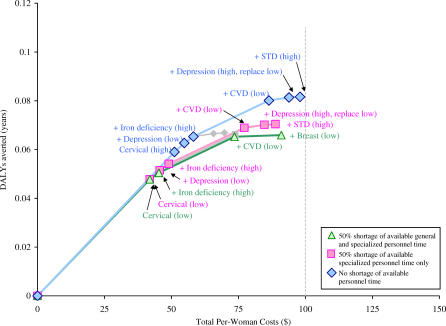
Packages of Interventions under a Lifetime Budget of $100 per Woman in AFR-D,EEach curve shows the order in which interventions are added (or substituted) when the budget is set at $100 per woman under the different scenarios of personnel time constraints: no personnel time constraints (blue), 50% constraint on specialized personnel time only (pink), and 50% constraint on both general and specialized personnel time (green). Curves in gray represent data from alternative lifetime budget set at $75 per woman (Figure 2). The dotted line represents the budget constraint.